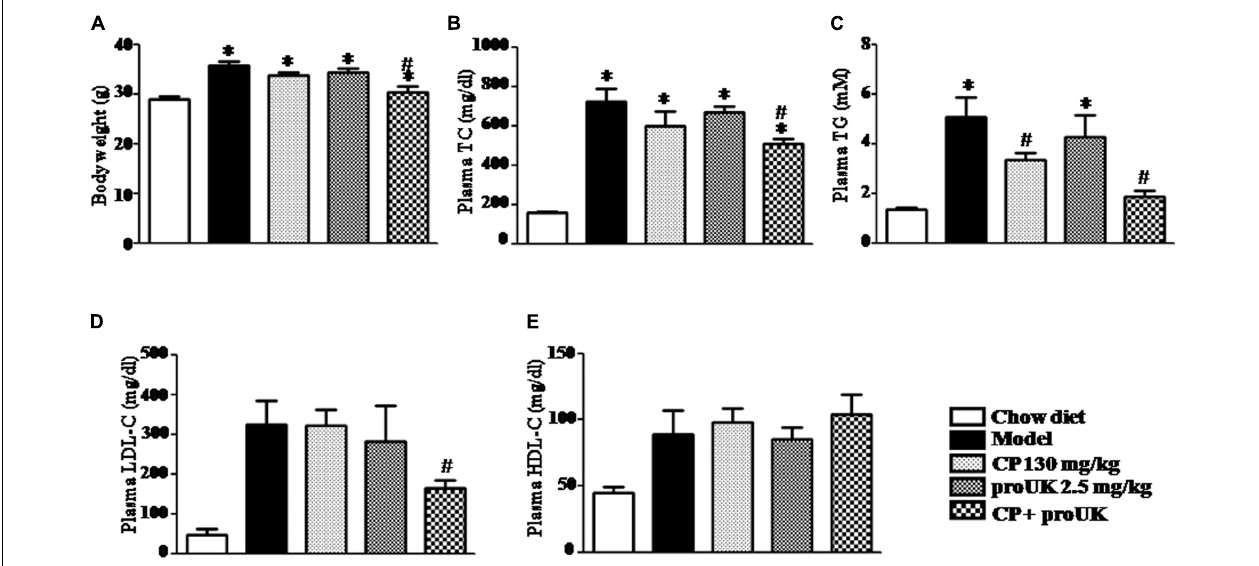
FIGURE 3 | CP plus proUK attenuates the increase in body weight and plasma TG, TC and LDL-C in the high fat diet-induced mice. (A) The body weight at the end of experiment. (B) Plasma TC level in different groups mice. (C) Plasma TG level in different groups mice. (D) Plasma LDL-C level in different groups mice. (E) Plasma HDL-C level in different groups mice. Total cholesterol, triglycerides, LDL-c, and HDL-c were quantified by enzymatic assays. The values are presented as the means SEM. n = 10. ∗ P < 0.05 vs. Chow diet mice, # P < 0.05 vs. Model mice.